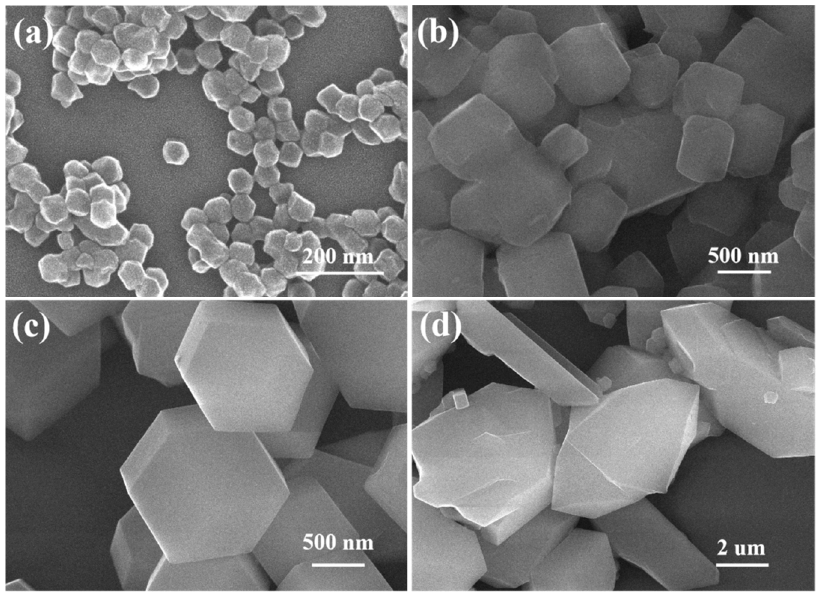
Figure 2. SEM images of ( a ) ZIF-8(1), ( b ) ZIF-8(2), ( c ) ZIF-8(3), and ( d ) ZIF-8(4).